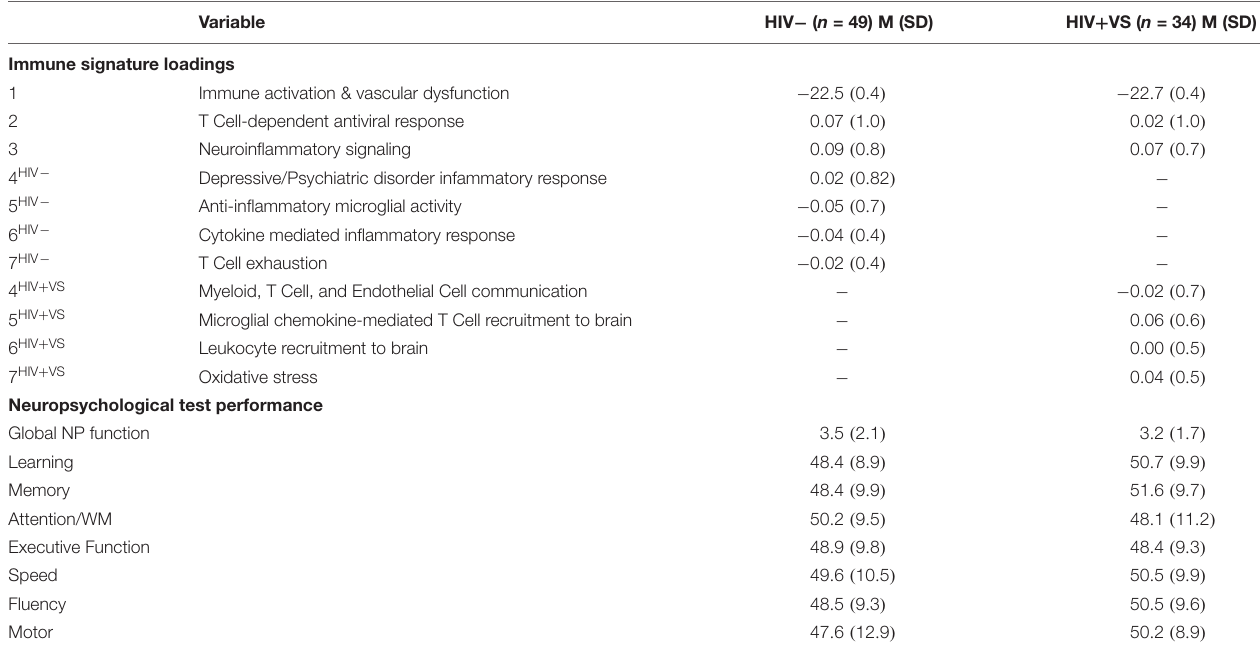
TABLE 5 | Descriptive statistics for immune signature loadings and cognitive function for the subset of participants with neuropsychological (NP) test performance data available.